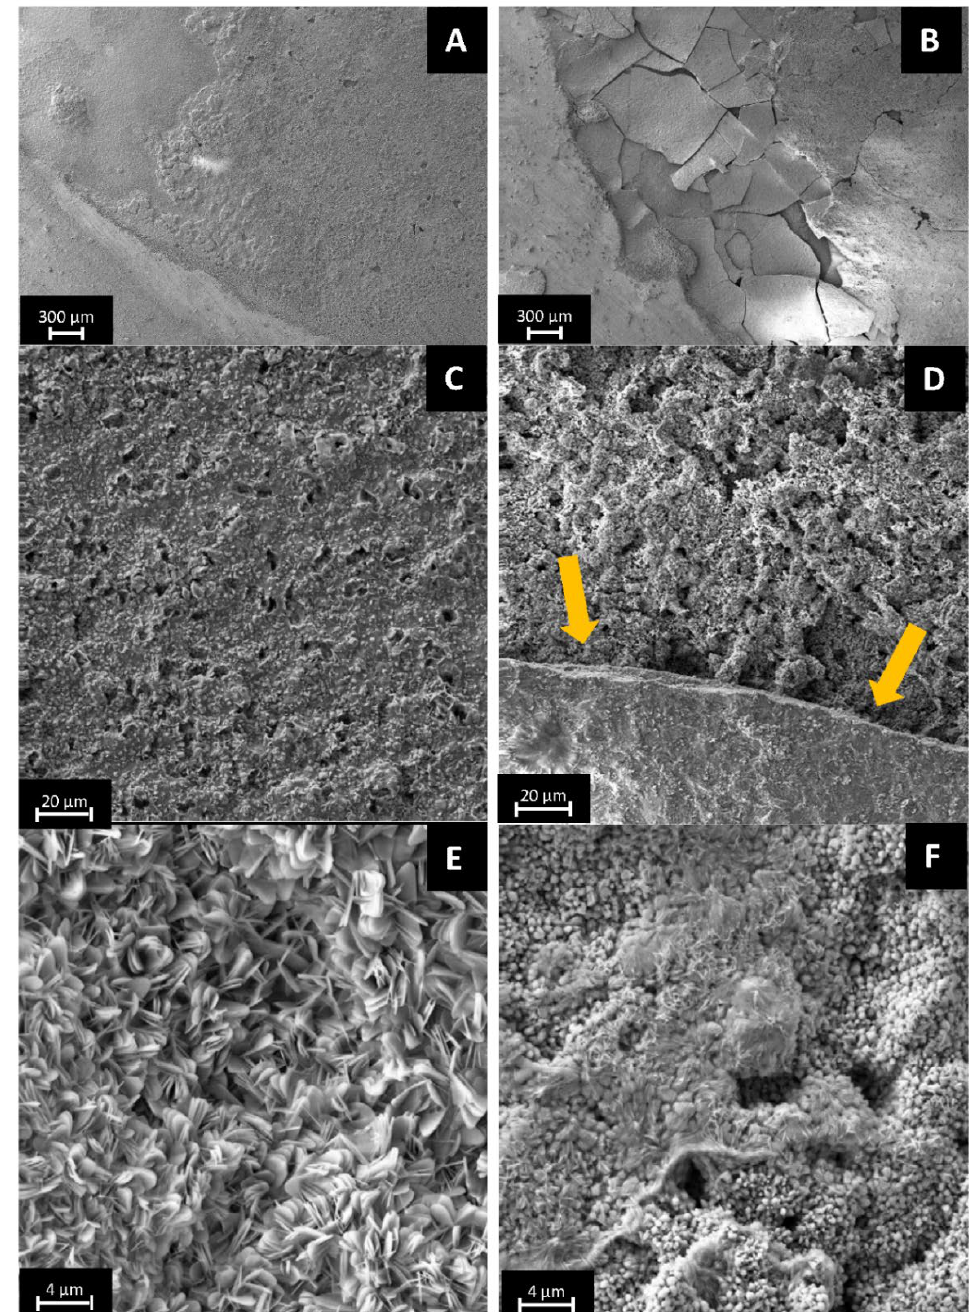
Figure 2. SEM images of the passivated Zn electrode ( A , E ) and after recovering the initial behavior ( B – F ). Arrows indicate the separation between the two different ZnO layers. Magnifications: 60× ( A , B ), 1.0 KX ( C , D ), and 5 KX ( E , F ).